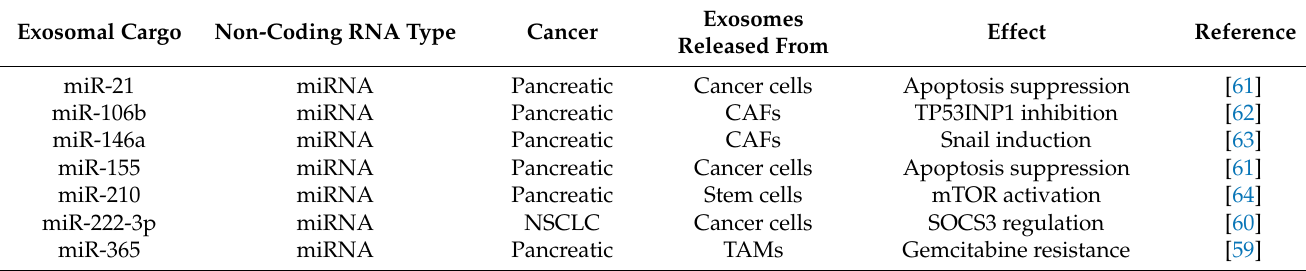
Table 3. Exosome-mediated gemcitabine